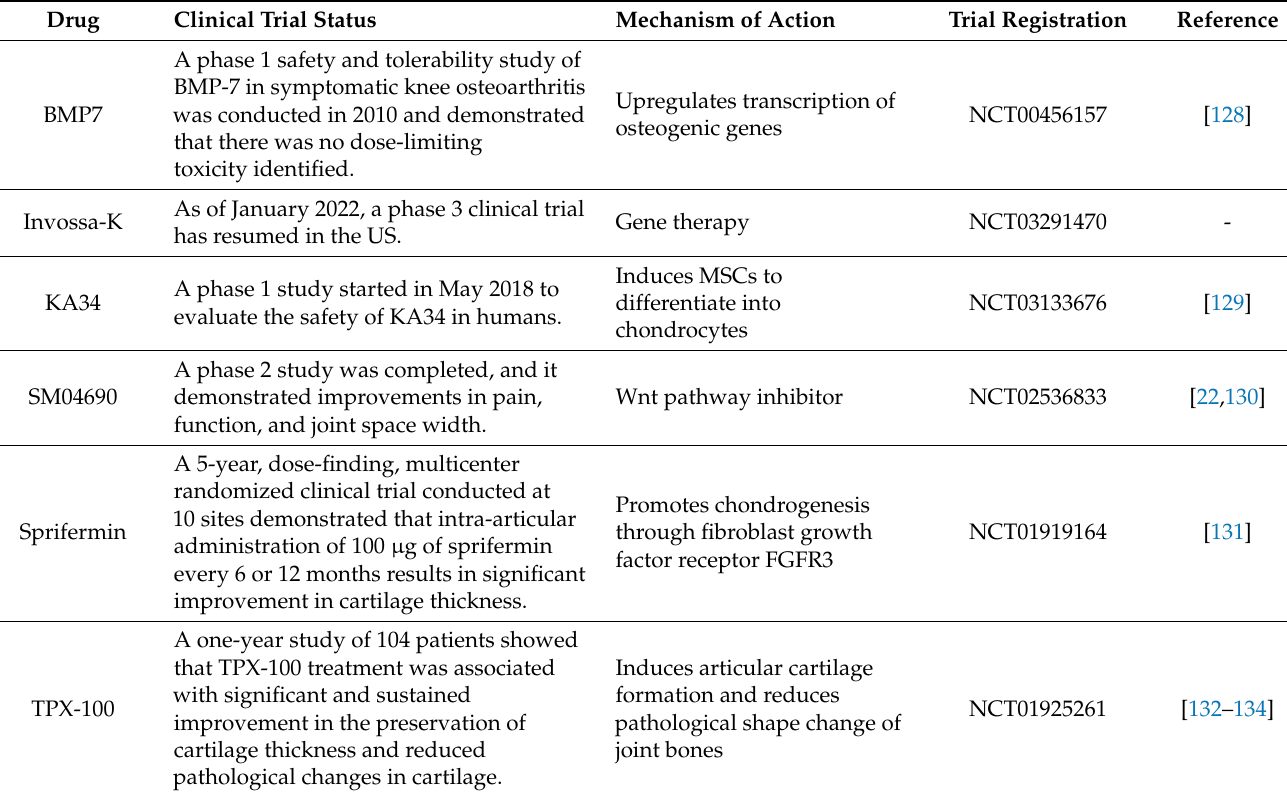
Table 6. The summary of some developed